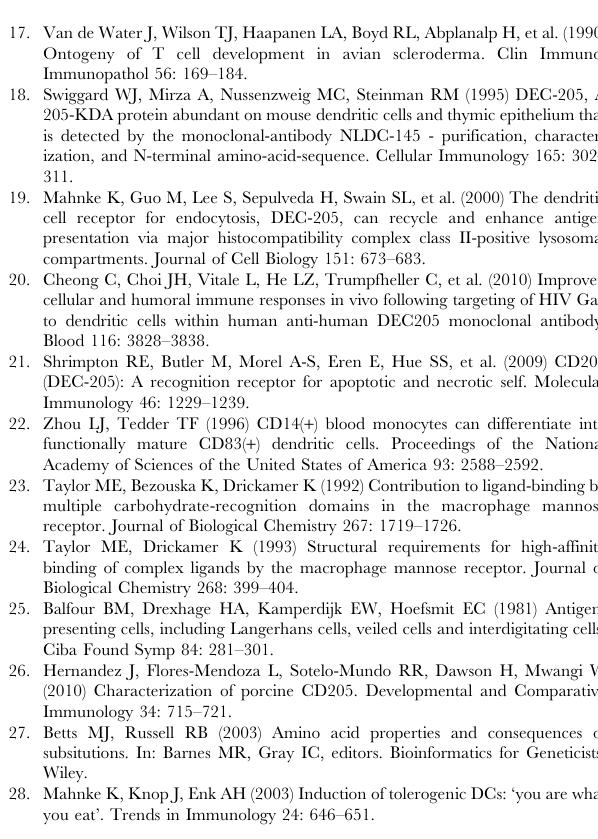
Figure S5 DEC205 antibody FG9 precipitates 260 kDa native protein. (PDF) Figure S6 GE8 monoclonal antibody recognises the chicken CD83 gene product expressed on transfected COS cells. (PDF) Figure S7 DEC205 expression in non-lymphoid tissues. (PDF) Table S1 Antibodies. (PDF) Table S2 Primers used for determining the chicken DEC205 sequence. (PDF) Table S3 Quantitative reverse transcription-PCR prim- er and probe